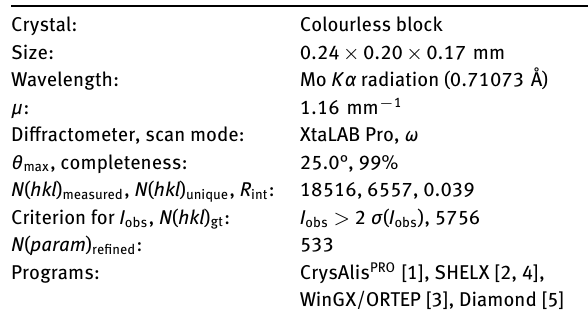
Table 1: Data collection and handling.